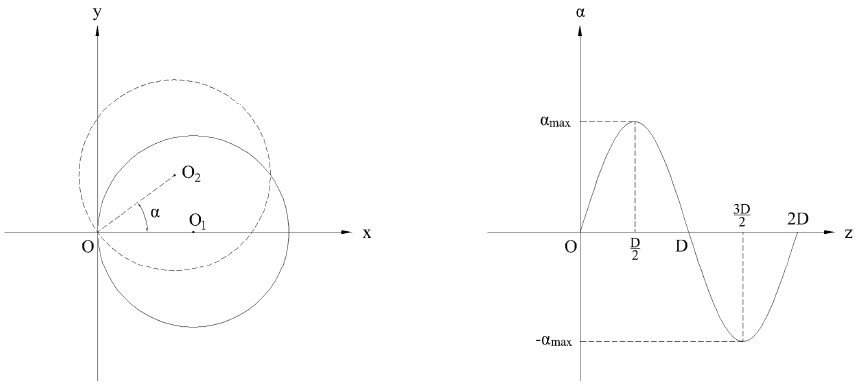
Figure 1. Definition of twisted angle and its variation relationship with the spanwise coordinate.